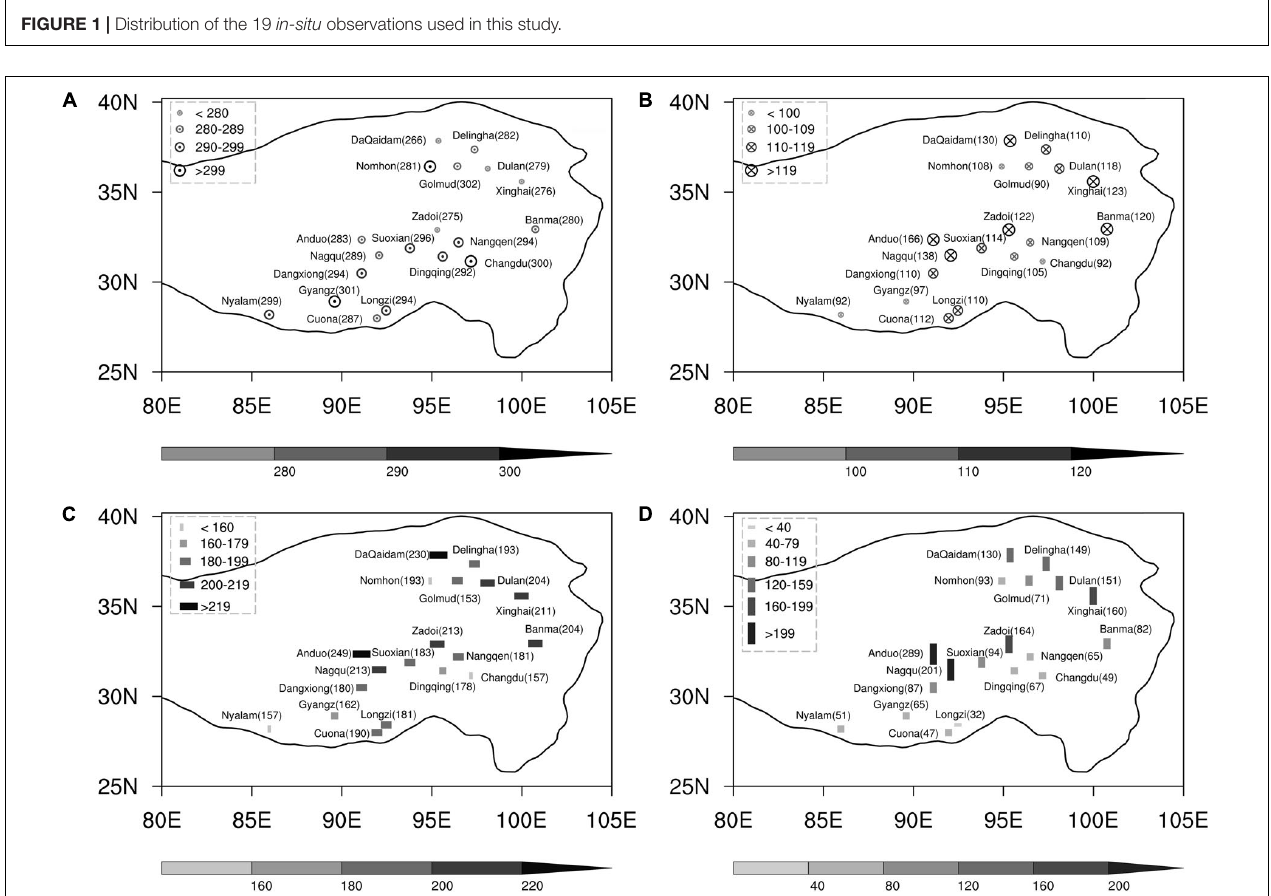
FIGURE 2 | Annual mean (A) onset date of soil freezing (unit: day), (B) the date when ground thawed completely (unit: day), (C) the length of the period of soil frozen (unit: day), (D) the maximum depth of soil frozen (unit: cm) from 1960 to 2019. The numbers in Figures. (A–C) represent the order of the day start from 01 January.